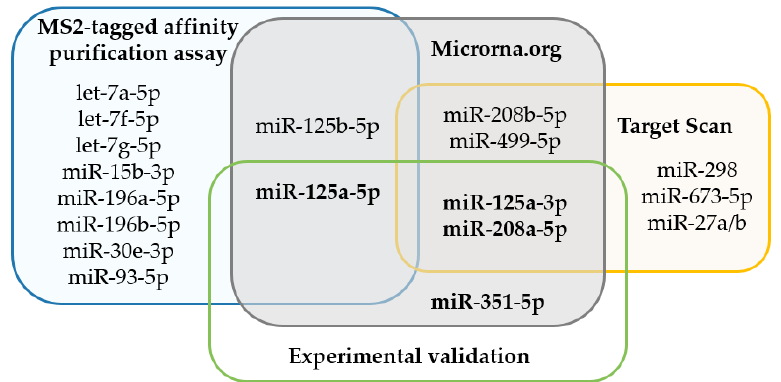
Figure 4. MiRNAs identified to target mu F8 3′UTR. Venn diagram of microRNAs identified by MS2- taq affinity assay, predicted to target F8 3′UTR by prediction algorithms (microrna.org, http://www.microrna.org), Target Scan and experimentally validated in vitro via luciferase assay and on MS1 cells.